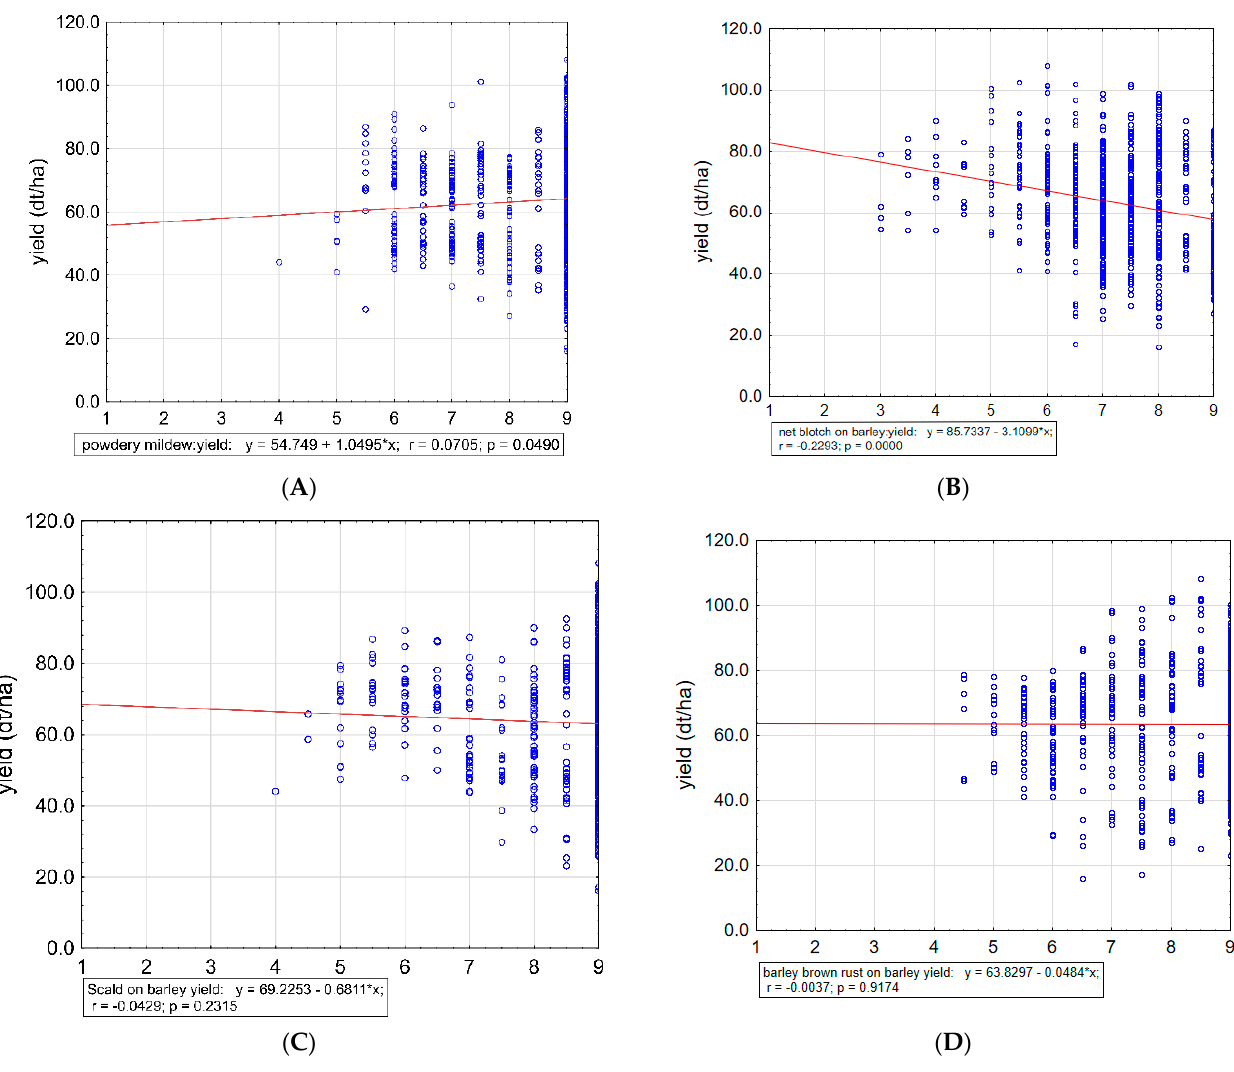
Figure 4. Impact of powdery mildew (PM), net blotch (NB), rhynchosporium (SB), and barley brown rust (BBR) resistance of 20 varieties growing in thirteen environments (L1–L13) scored in 2016, 2017, and 2018 on their yield potential (dt/ha). Figures present regression analysis models, which estimate relationship between PM resistance ( A ), NB resistance ( B ), SB resistance ( C ), and BBR resistance ( D ) and yield potential frequency index.